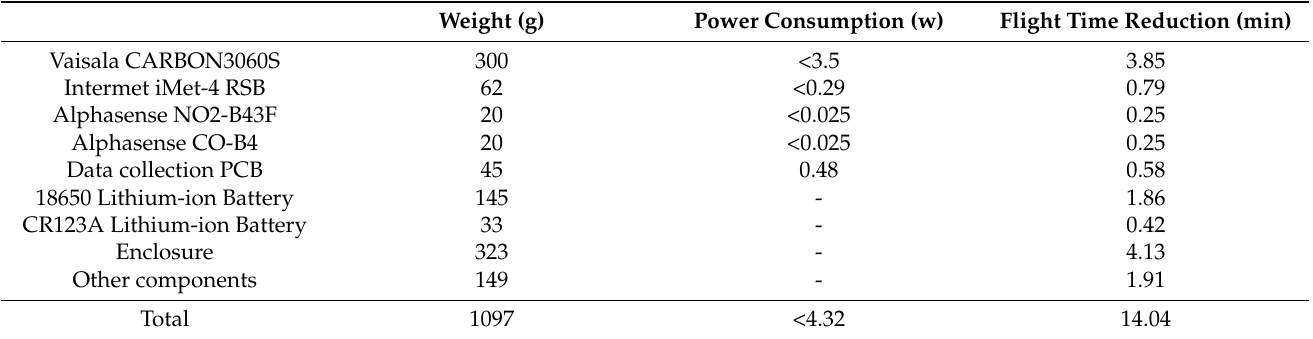
Table 1. Payload component details with individual information about their weights, power con- sumptions and influences on maximum flight time of Matrice